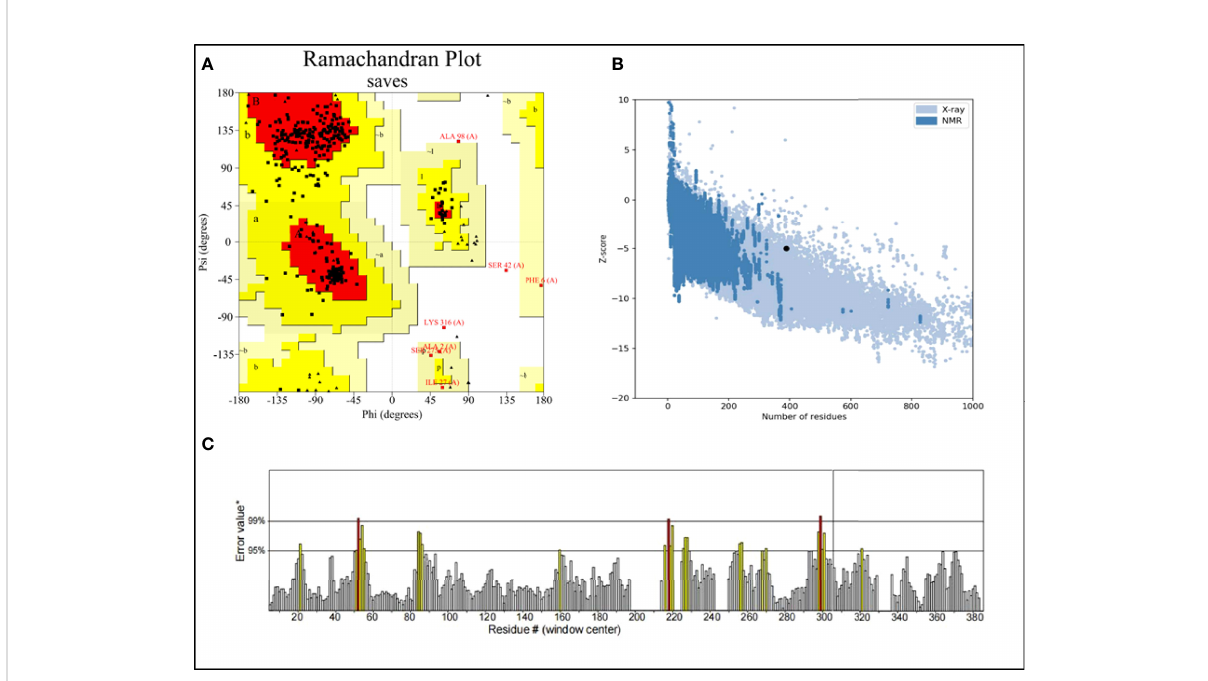
FIGURE 3 (A) Ramachandran plot of the vaccine. Red denotes the most favored region, dark yellow denotes the additional allowed region, light yellow denotes the generally allowed region, and white denotes the disallowed region; (B) three dimensional (3D) structure of the vaccine was validated by ProSA with a Z score of -5.01; (C) 3D structure of the vaccine was validated by ERRAT with an ERRAT score of 92.42.